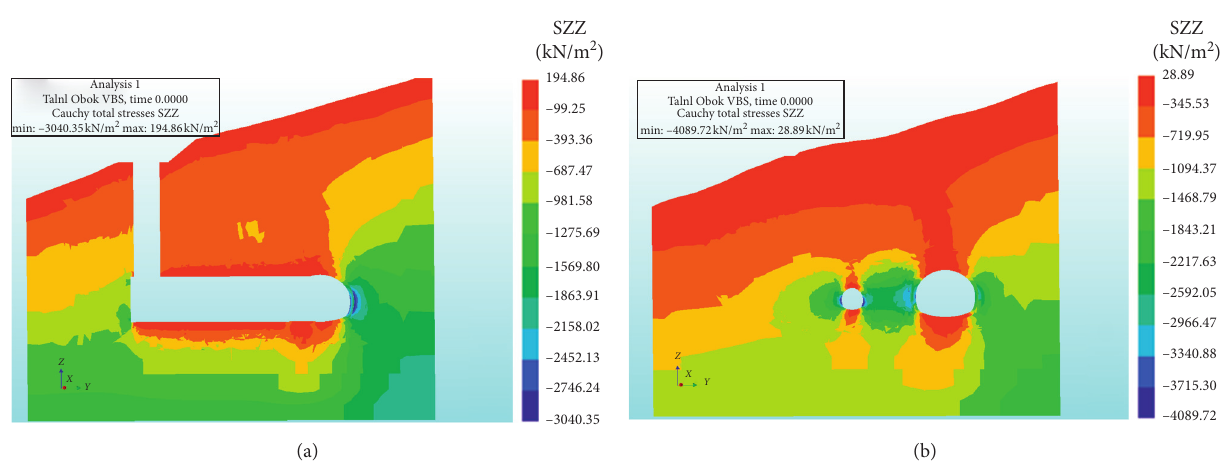
Figure 17: Total vertical stresses in two cross sections after tunnel excavation.